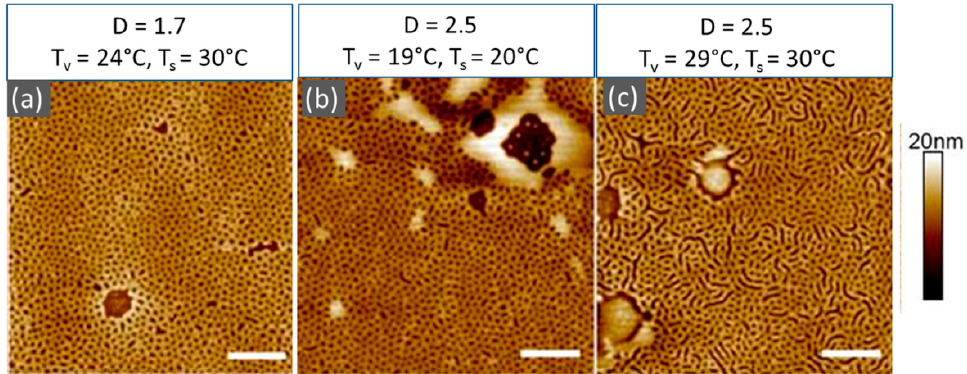
Figure 6. SFM height images of the surface morphology of 40 nm thick PS-PVP films processed under indicated temperature sets T v / T s . D is the degree of swelling calculated from the measurements of the swollen and the dry film thicknesses as h sw / h dry . The swelling curves for the films shown in ( a ), ( b ), and ( c ) are presented in Figure 2 (c), (a), and (b), respectively.